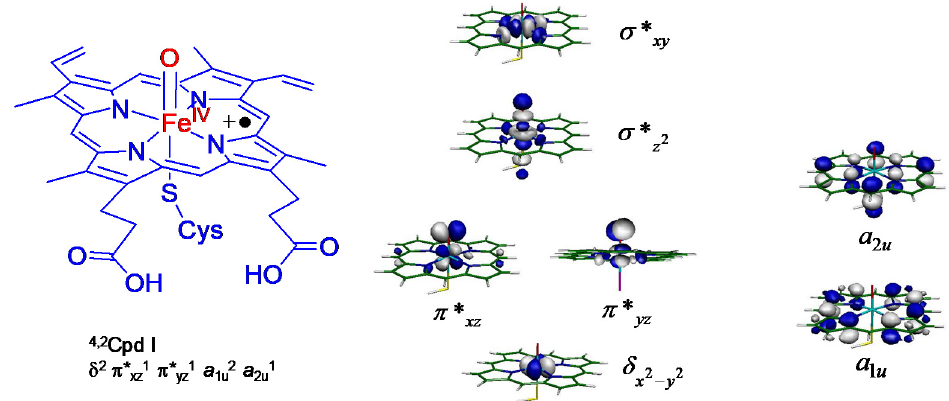
Figure 2. Electronic orbitals of doublet and quartet Cpd I with orbital occupation.